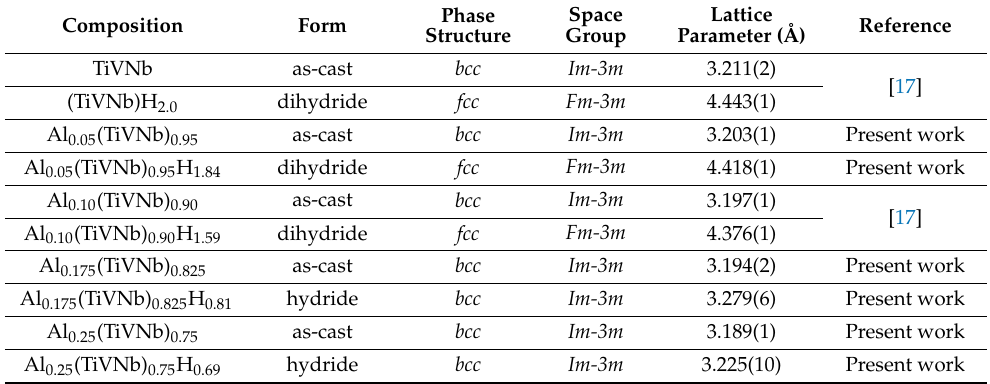
Figure 1. ( a ) XRD patterns of Al x (TiVNb) 1 − x alloys with x = 0 [17], 0.05, 0.10 [17], 0.175, 0.25 ( λ = 1.5406 Å). ( b ) bcc lattice parameters as a function of Al content. Table 2. Lattice parameters of the Al x (TiVNb) 1 − x (x = 0 [17], 0.05, 0.10 [17], 0.175, 0.25) series in the form of as-cast alloys and hydrides.